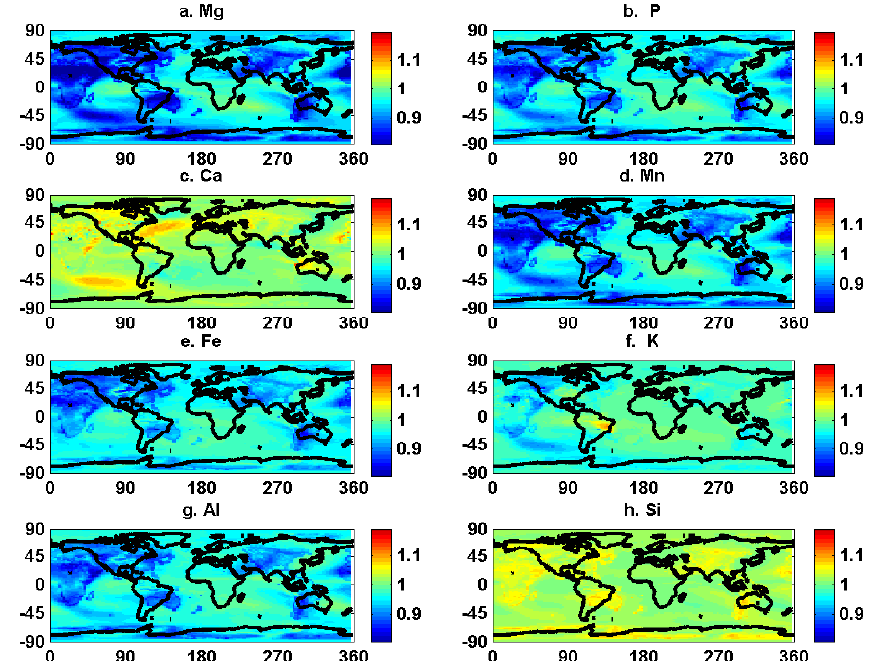
Figure 5. Ratio of mass fractions of elements in dust deposition to that in atmospheric dust: (a) Mg, (b) P, (c) Ca, (d) Mn, (e) Fe, (f) K, (g) Al, (h) Si. Elemental ratios shown here are calculated using the annual mean element deposition divided by the annual mean dust